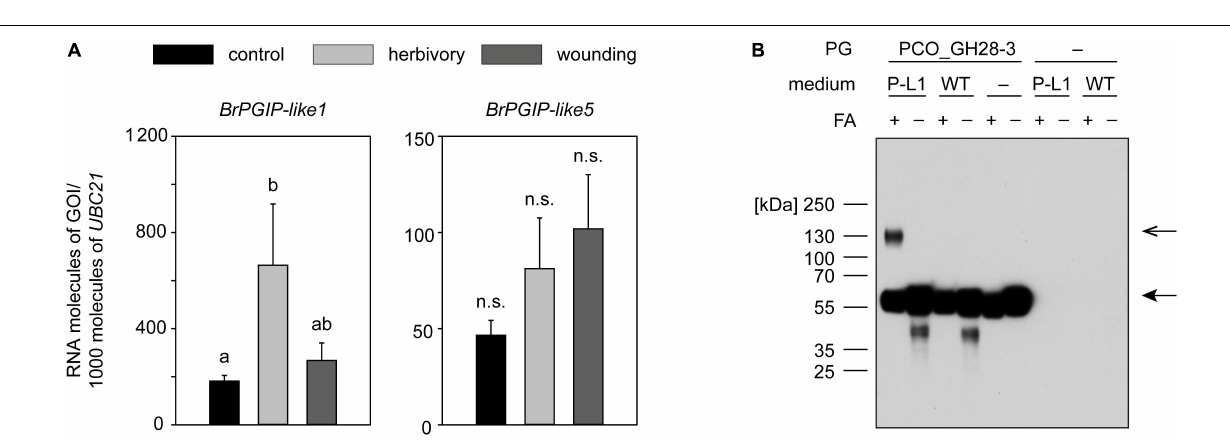
FIGURE 4 | Regulation of BrPGIP-like genes in response to P. cochleariae feeding and mechanical wounding, and interaction of BrPGIP-like1 with PCO_GH28-3. (A) The expression levels of BrPgip-like1 and -like5 were quantified by RT-qPCR in untreated control plants (black), after P. cochleariae feeding (light gray) and mechanical wounding (dark gray), respectively. Transcript abundance is expressed as RNA molecules of interest (GOI) per 1000 RNA molecules of reference gene UBIQUITIN-CONJUGATING ENZYME 21 ( UBC21 ). Gene expression levels were compared between the three treatments ( n = 5). Letters indicate significant differences ( p < 0.05) between the groups based on an ANOVA on ranks or ANOVA followed by a Student–Newman–Keuls post hoc test. Error bars indicate the SEM. n.s., not significant. (B) Culture medium from BrPGIP-like1-expressing (P-L1) as well as wild-type (WT) yeast was incubated with PCO_GH28-3 and cross-linked with formaldehyde (FA). PCO_GH28-3 was detected in a western blot with an anti-V5 antibody. Arrows indicate the expected size of BrPGIP-like1 (closed arrowhead) and PCO_GH28-3–BrPGIP-like1 complex (open